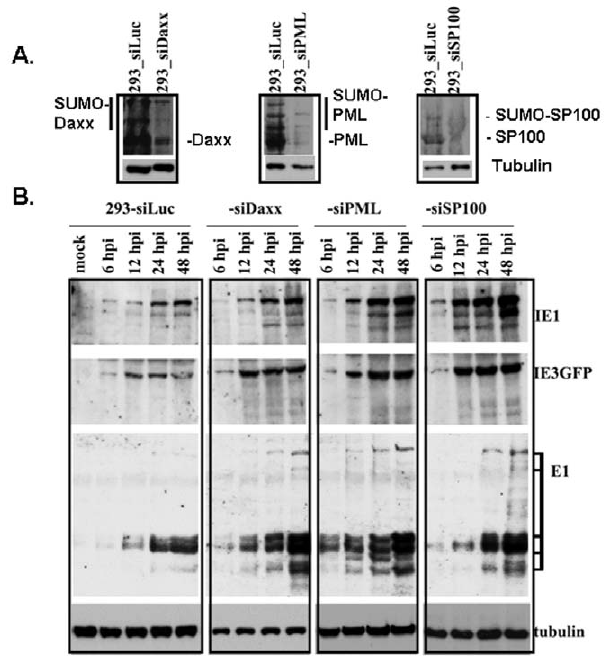
Figure 6. Western blot assay to detect the effects of ND10 proteins (Daxx, PML, and SP100) on MCMV protein produc- tion. A . siRNA to knockdown the ND10 protein. One hundred pmol of siRNA (the sequences are shown in Materials and Methods) was transfected into HEK293 cells for 24 hours, the whole-cell lysates were run on PAGE gels and probed with antibodies to the targeted proteins, as indicated. Tubulin was used as a house-keeping gene for sample- loading control. siRNA-Luc was used as control. B . One hundred pmol of siRNA was used to transfect HEK293 cells in a 24-well plate; 12 hours after transfection, the cells were infected with MCMVIE1/3gfp at an MOI of 1; the cells were harvested at the time indicted, and the whole-cell lysates were used to detect viral-protein